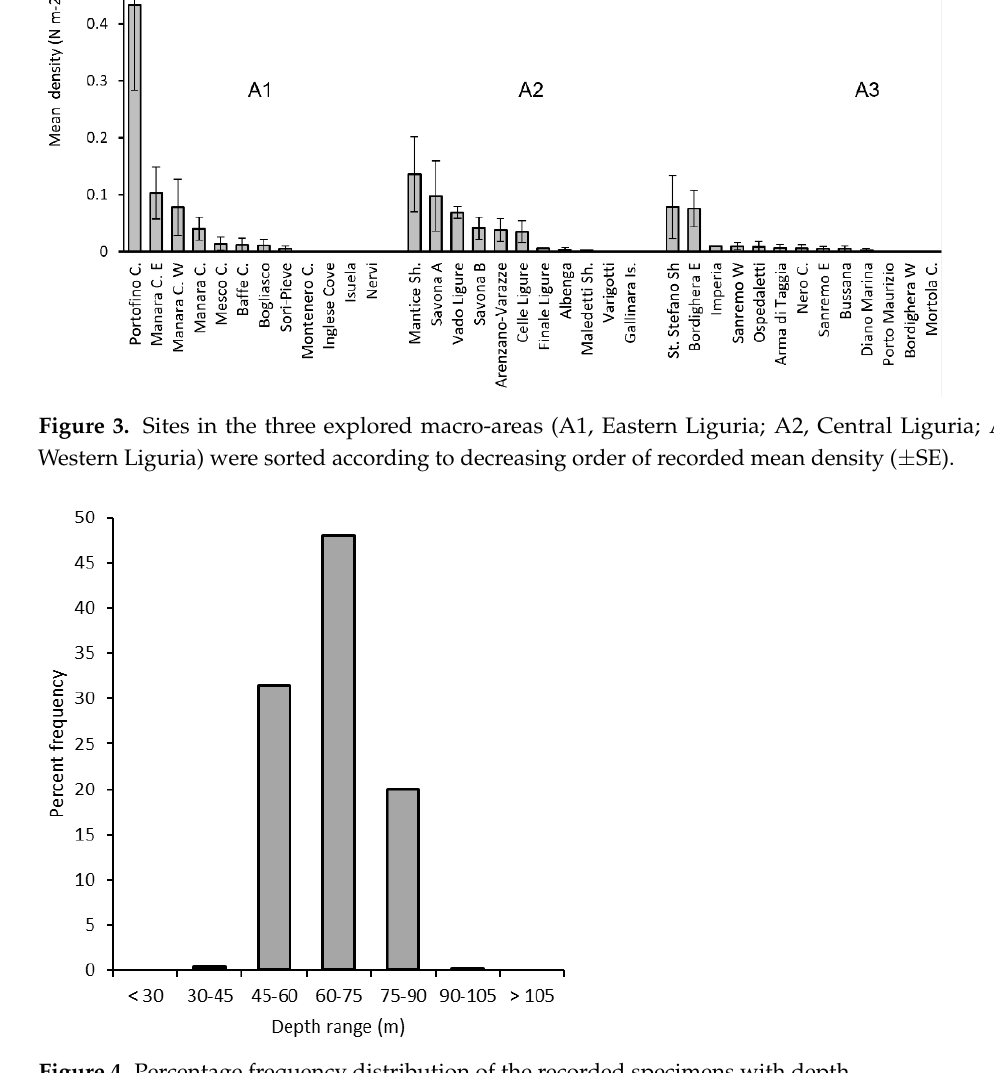
Figure 4. Percentage frequency distribution of the recorded specimens with depth.